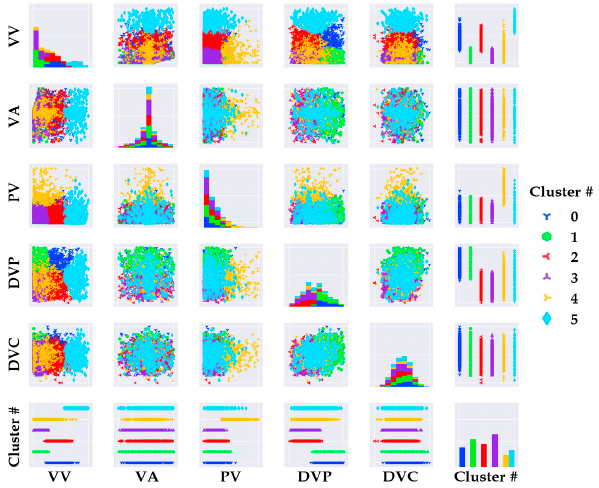
Figure 11. Result of correlation analysis using scatter matrices by clusters.